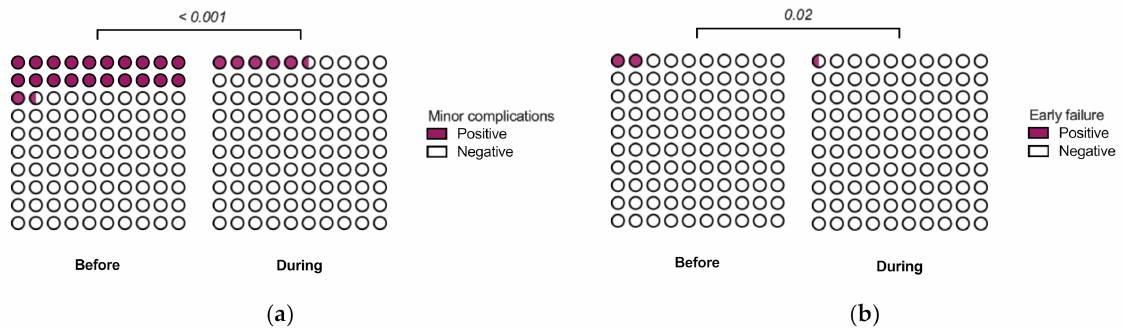
Figure 4. Postoperative complications. ( a ) Minor complications. Positive if patient bleeding, sup- puration, swelling, local infection, hematoma, or temporary neurosensory disturbance was either reported by the patient or observed during a follow-up visit. ( b ) Early (i.e., before loading) implant failures. All p -values using the Chi-squared test with the Holm–Sidak correction for multiple